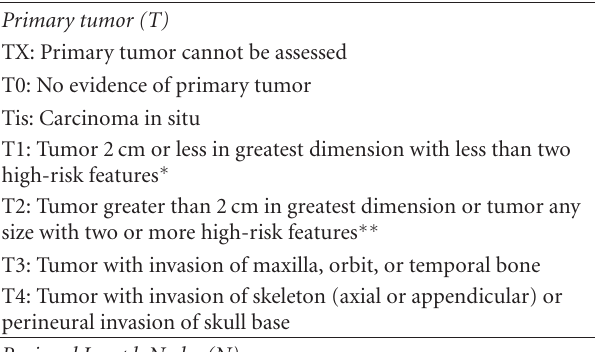
Table 2: AJCC TNM staging for cSCC